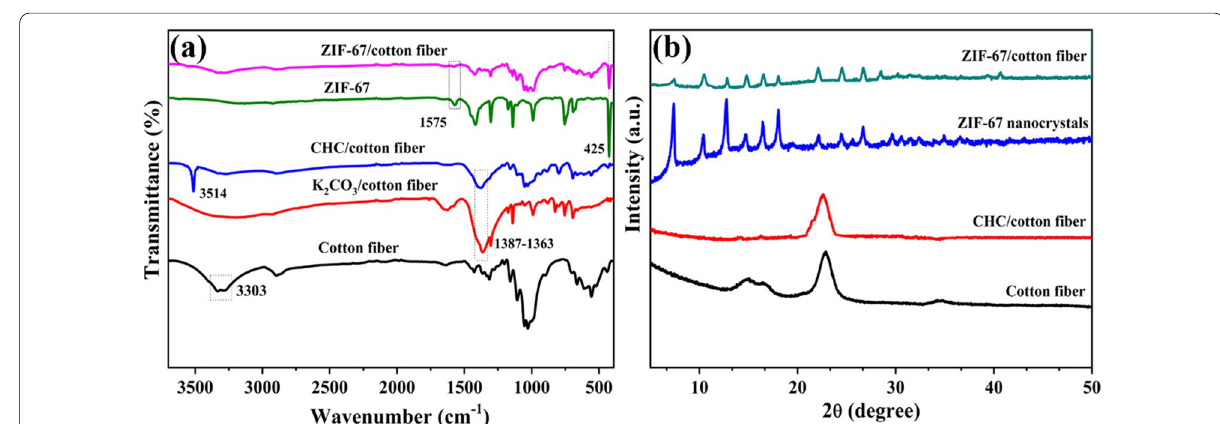
Fig. 1 FTIR spectra ( a ) and XRD patterns ( b ) of the